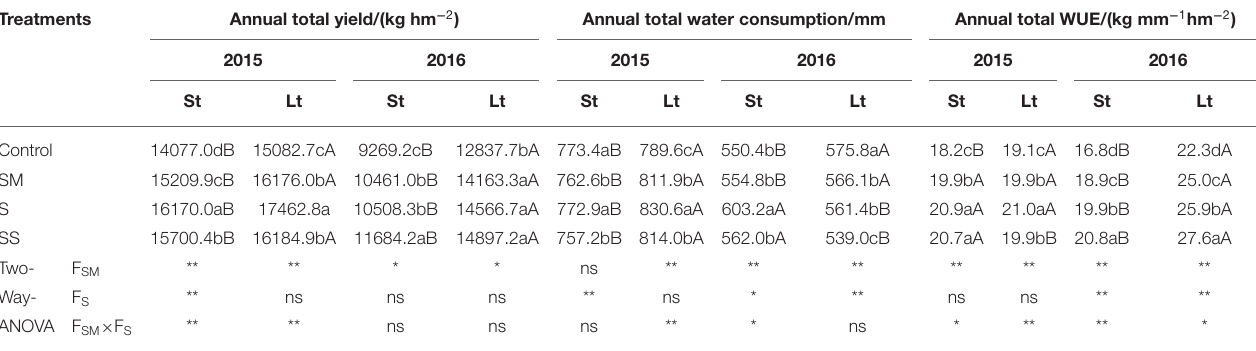
TABLE 6 | Annual total yield, water consumption and water use efficiency of wheat and maize under the Control, SM, S and SS treatments in different years.